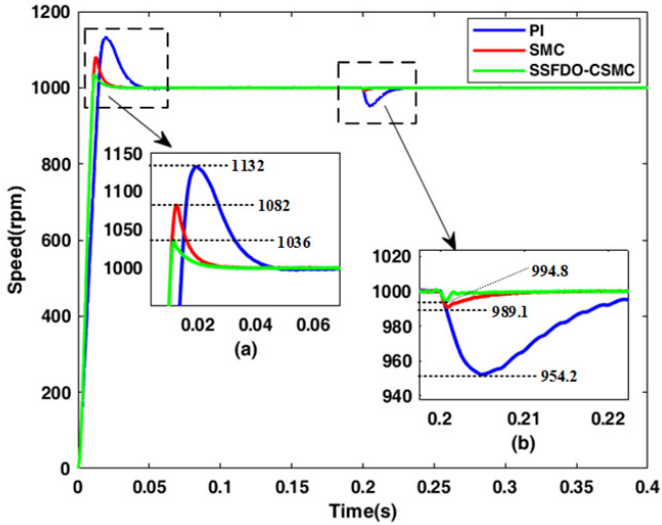
Figure 9. Speed response under step load of 5 N · m: ( a ) starting performance, ( b ) disturbance